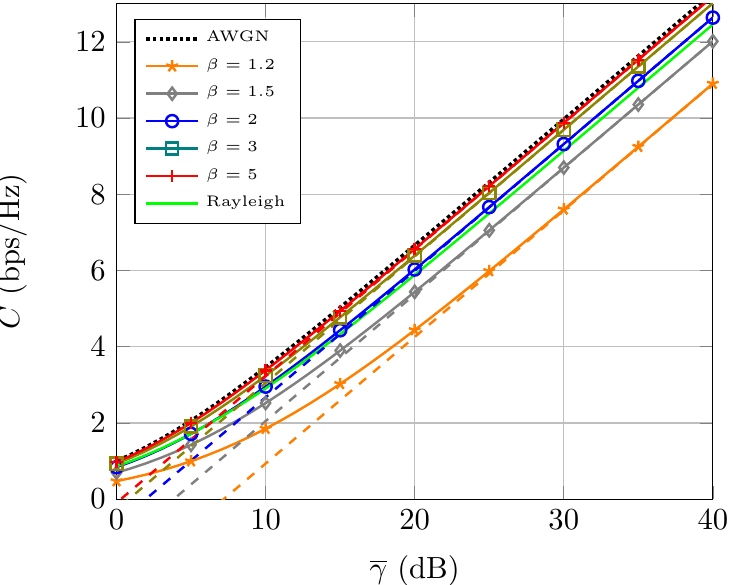
Figure 4. Average capacity vs. γ under L -distributed fading for different values of β . Solid lines cor- respond to the theoretical expressions in (11). Dashed lines correspond to the asymptotic expressions in (12). The case of Rayleigh fading is included as a reference. Markers denote MC